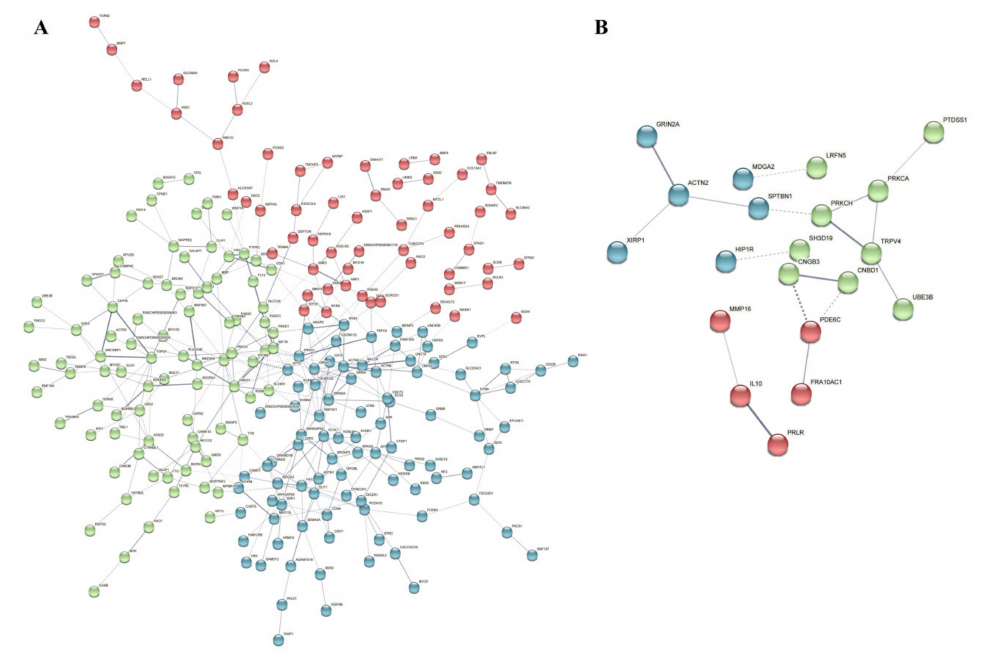
Figure 5. Protein–protein interaction (PPI) network analysis. ( A ) PPI network analysis of population specific SNP annotated 363 genes in the popC (Hainan Black goat) group. Among them, 235 genes were visualized, and the other genes that were not enriched into any network were not visualized. ( B ) PPI network analysis of population specific SNP annotated 80 genes in the other group. Twenty of the genes were visualized, and the other genes that were not enriched into any network were not